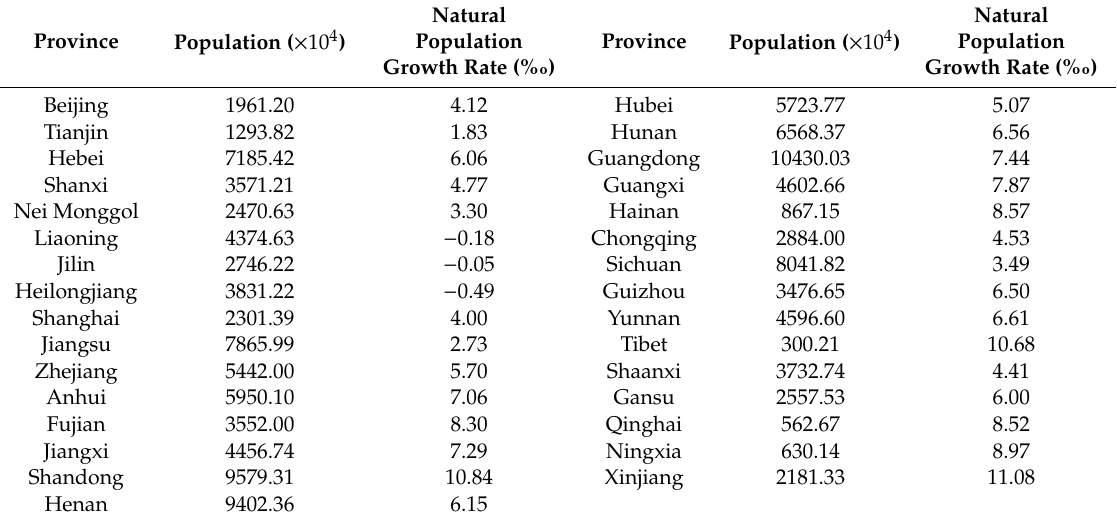
Table A1. Population and natural population growth rate in 2016 by